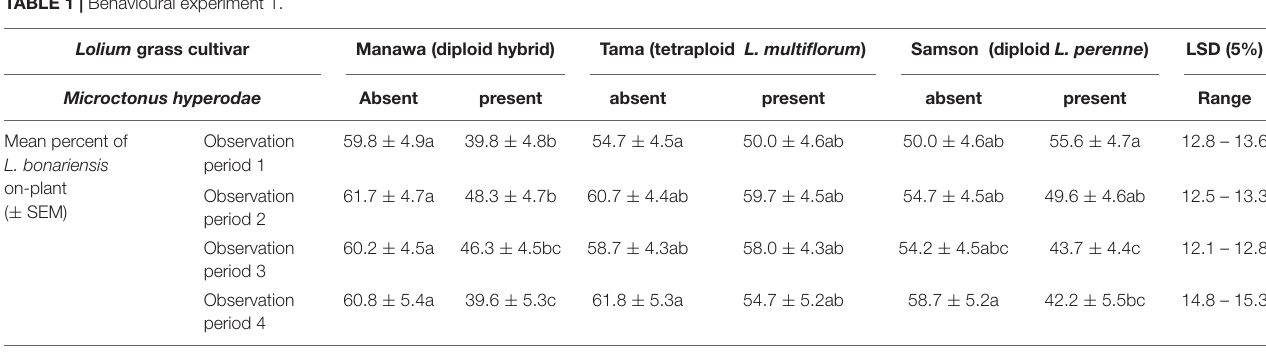
TABLE 1 | Behavioural experiment